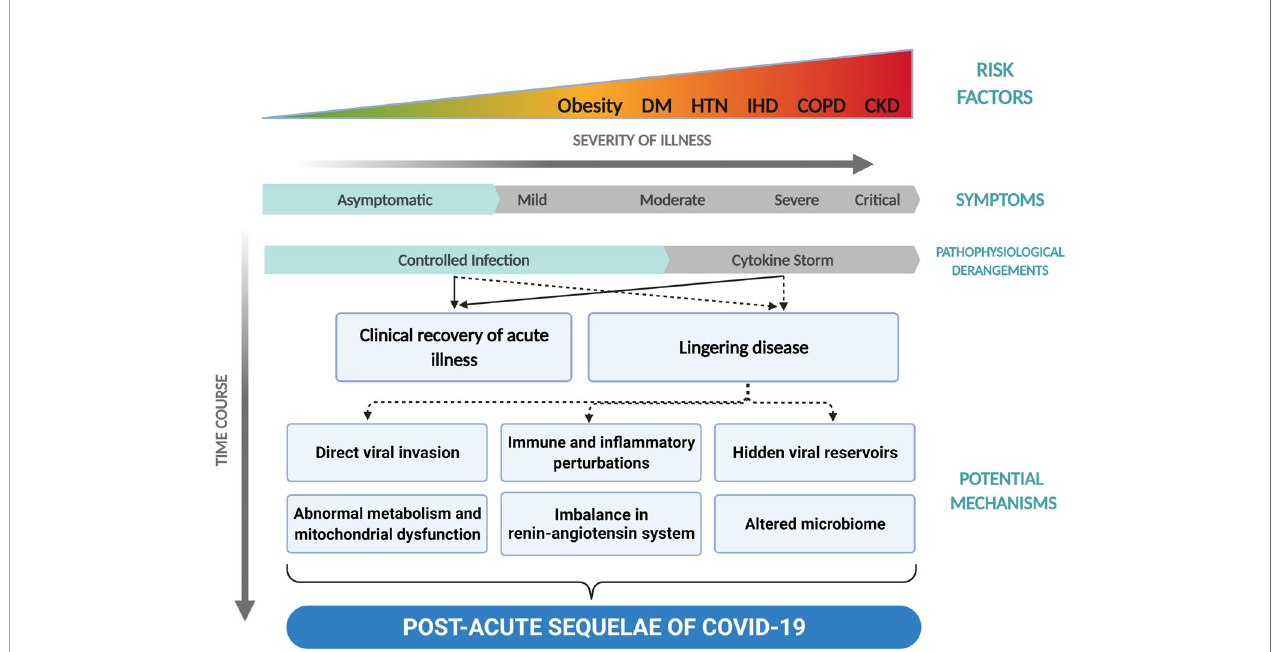
FIGURE 1 | Development of post-acute sequelae of COVID-19 (PASC). This fi gure illustrates the development of PASC with time across the spectrum of severities presented by COVID-19. DM, diabetes mellitus; HTN, hypertension; IHD, ischemic heart disease; COPD, chronic obstructive pulmonary disease; CKD, chronic kidney